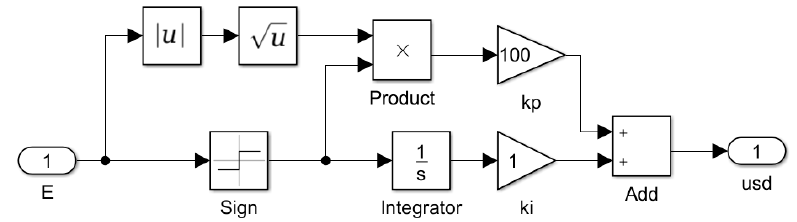
Figure 10. Simulation model of the flux regulator.